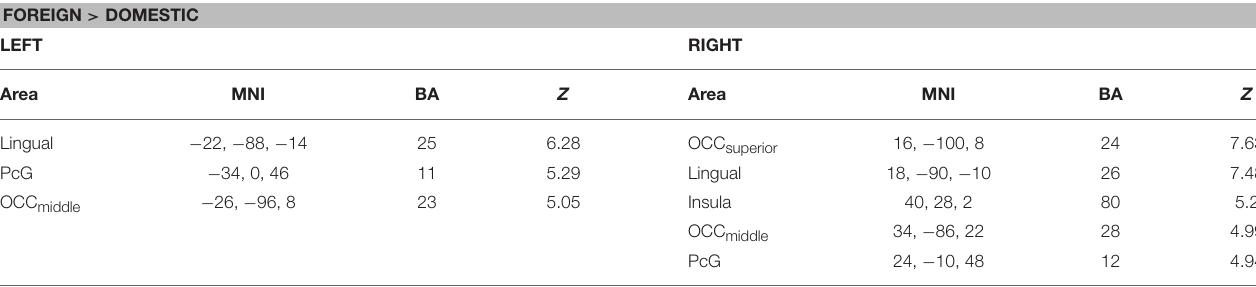
TABLE 2 | Brain areas showing greater activity during observation of foreign, as opposed to domestic, health warning labels. FOREIGN > DOMESTIC LEFT